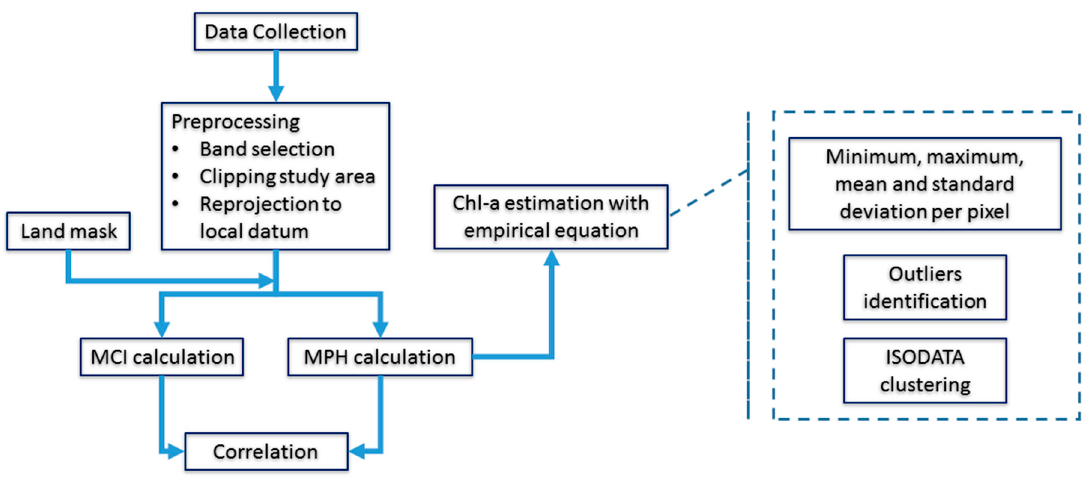
Figure 3. Work flow chart. maximum chlorophyll index (MCI) and maximum peak-height (MPH).